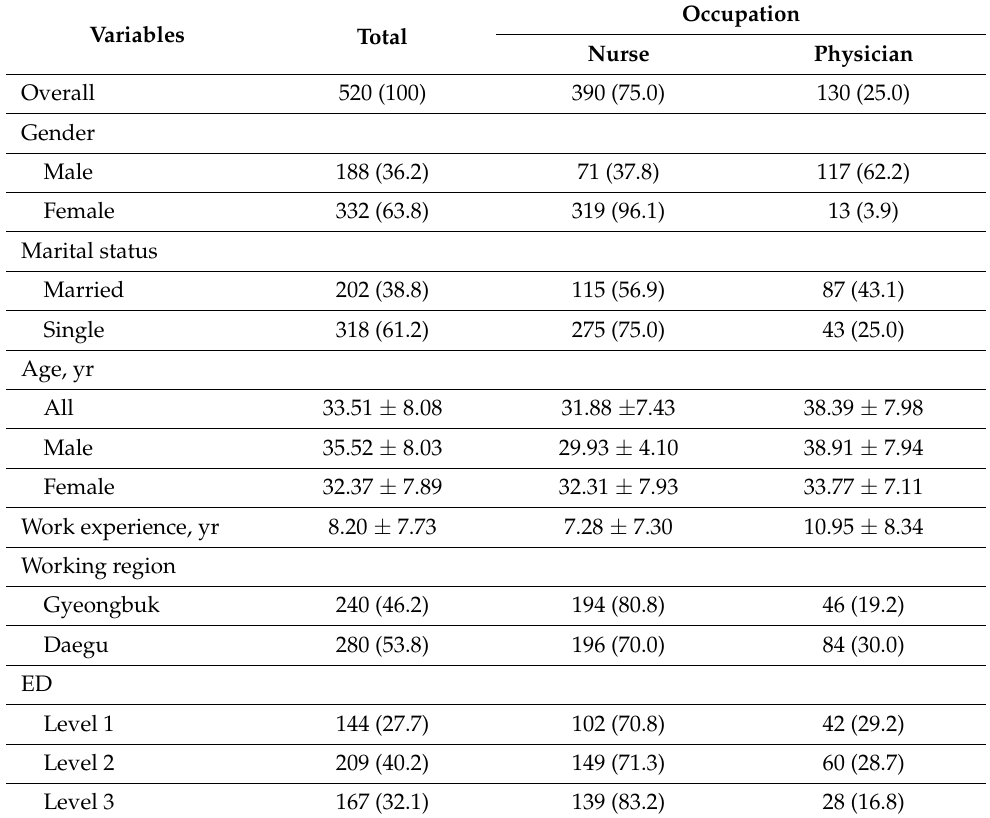
Table 1. Demographic characteristics of